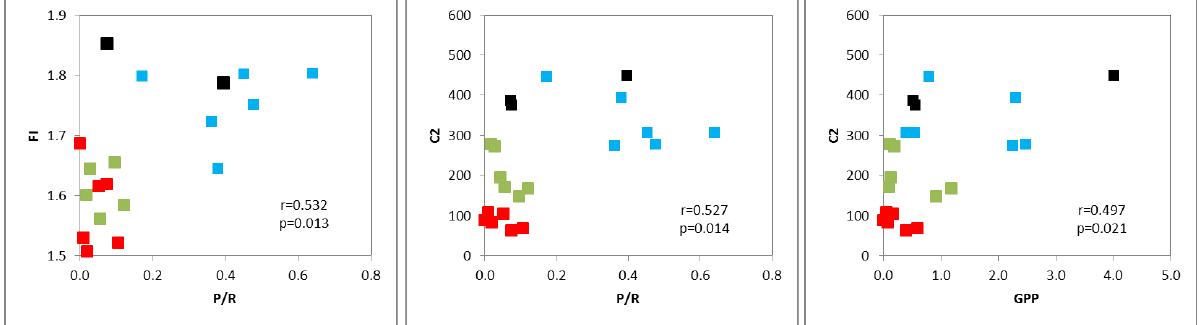
Fig. 8. Spearman’s rank correlation between P/R and FI, P/R and C2, and GPP and C2. With an increasing phototrophic character ( P/R ) and a general increase of primary production (GPP) also the amount of autochthonously derived DOM increased (as indicated by increases in FI and C2). Colours of squares indicate Zillierbach (green), Ochsenbach (red), Rappbode (blue), and Hassel